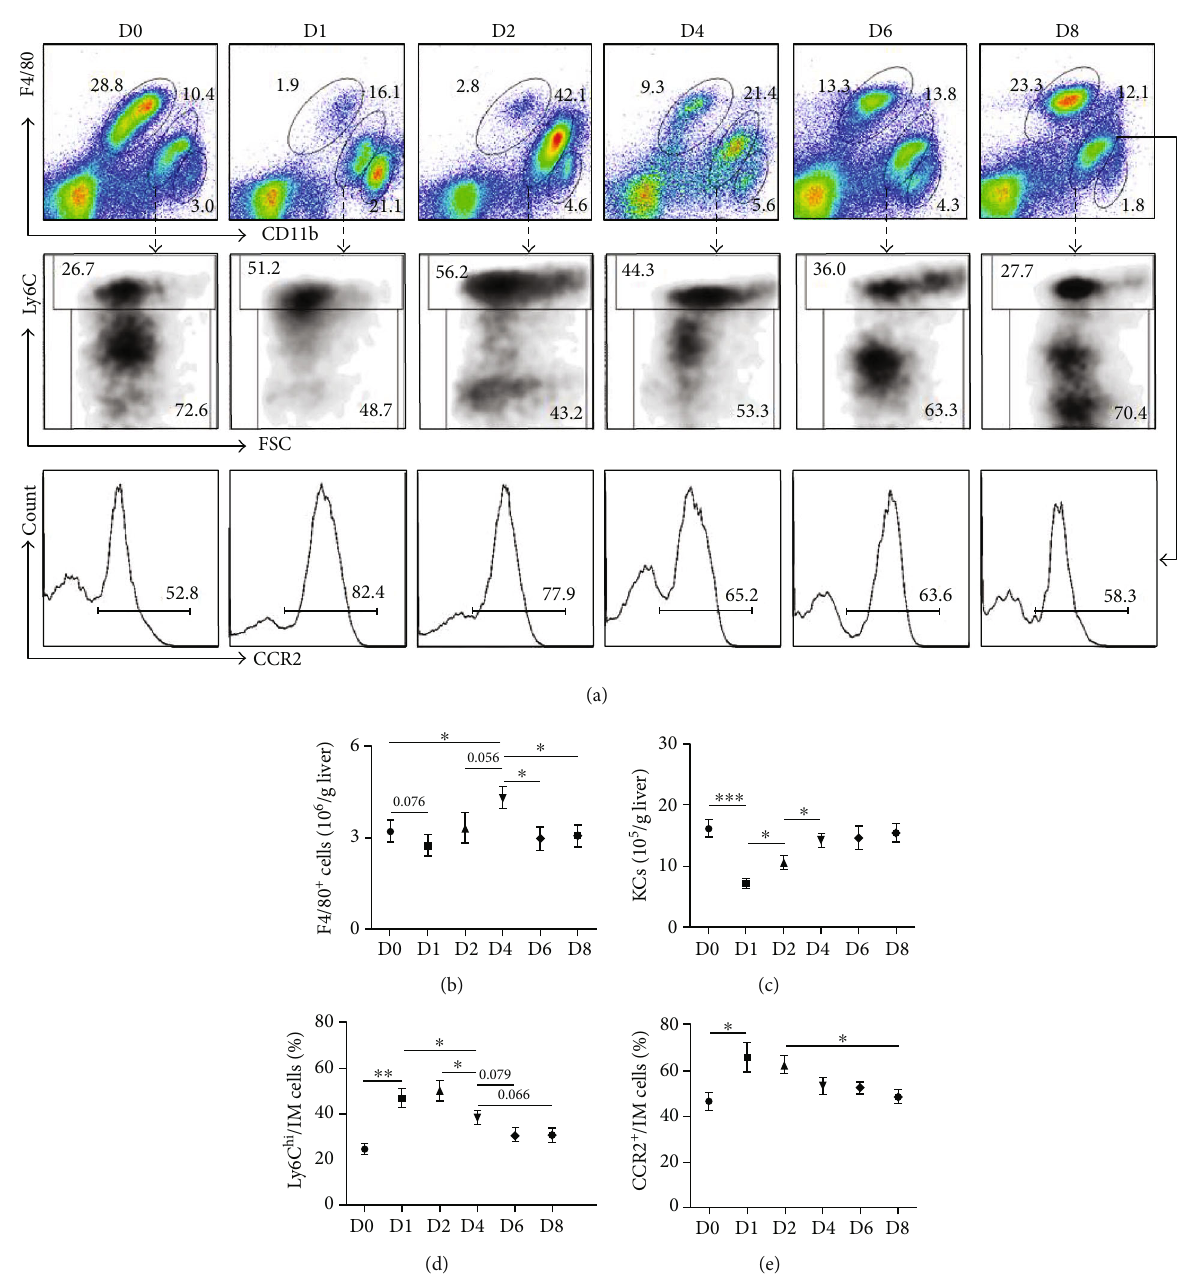
Figure 2: The reduction and restoration of Kup ff er cells and the transformation of ly6C hi in fi ltrated macrophages after PHx. (a) C57BL/6 mice were sacri fi ced at day 1, 2, 4, 6, or 8 after 2/3 PHx or sacri fi ced immediately after sham operation. The subpopulation of HNPCs was analyzed by FACS with anti-F4/80, anti-CD11b, anti-ly6C, and anti-CCR2 antibodies. The number of (b) F4/80 + macrophages and (c) F4/ 80 hi CD11b + KCs in (a) was determined and quantitatively compared. The percentage of (d) ly6C hi IMs (D) and (e) CCR2 + IMs in (a) was determined and quantitatively compared. Bars = means ± SD , n = 8 . ∗ P < 0 : 05 , ∗∗ P < 0 : 01 , and ∗∗∗ P < 0 : 001